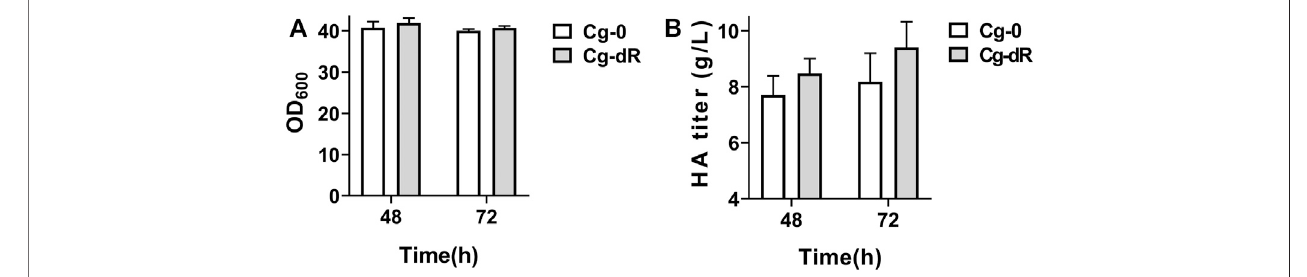
FIGURE 2 | Cell growth and HA titer comparison of Cg-dR and control Cg-0. (A) OD 600 ; (B) HA titer. Experiments were performed in triplicate.